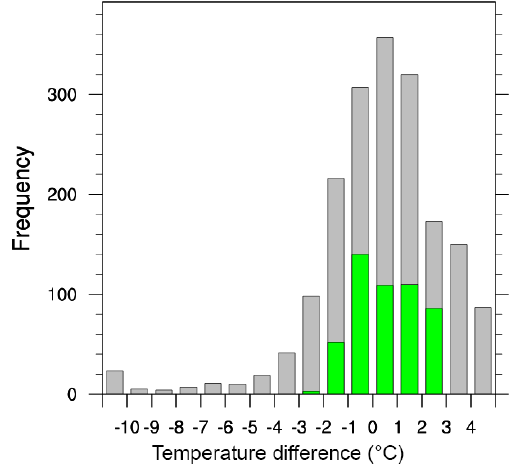
Figure 12. The distribution of global annual mean 2m temperature difference between ensemble members and observations averaged from 1950 to 1980CE. Grey and green bars represent the 2000 en- semble members and the top-performing 500 ensemble members,